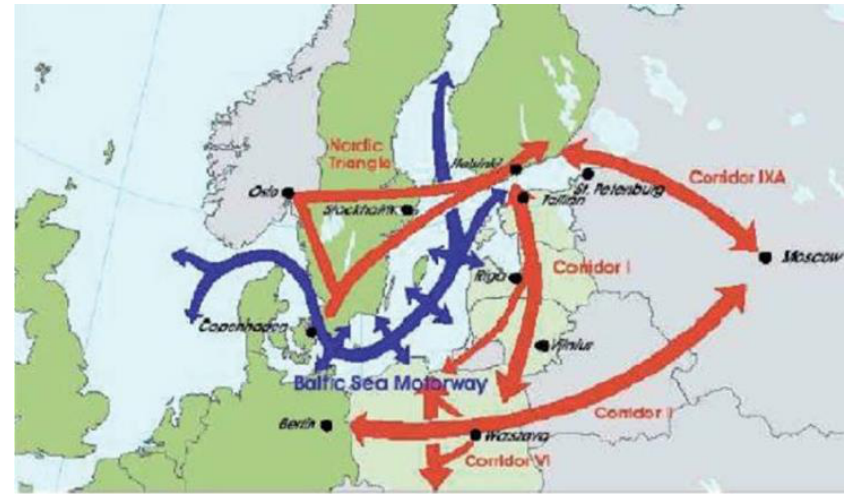
Figure 1. Transport corridors in the Baltic Sea region. Source: Adapted from Ref. [61]. The Baltic Sea is surrounded by nine countries. Four countries (Lithuania, Latvia, Estonia and Russia) have different coastlines and different numbers of seaports comprise the Eastern Baltic. Figure 2 below shows the main ports on the eastern Baltic Sea coast and their geographical location.